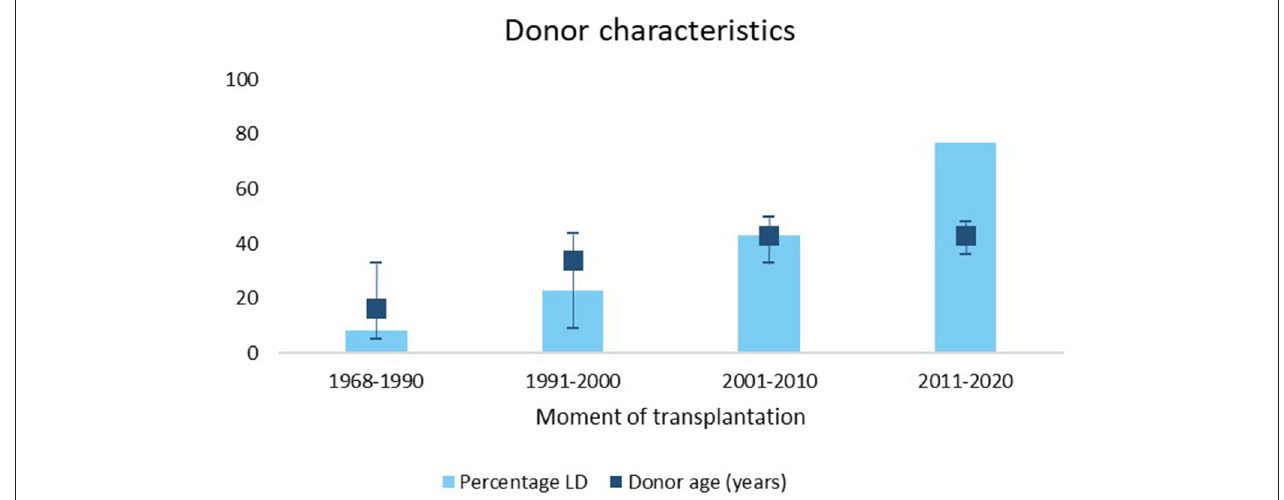
FIGURE 3 | Percentage of living donors and IQR donor age stratified for different time periods. LD, living